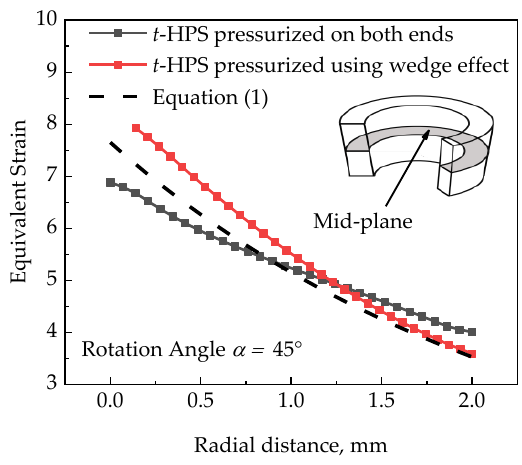
Figure 4. Equivalent strain plotted as a function of the radius position on the mid-plane for the two pressurizing alternations of t -HPS, in comparison with analytical solution Equation (1).